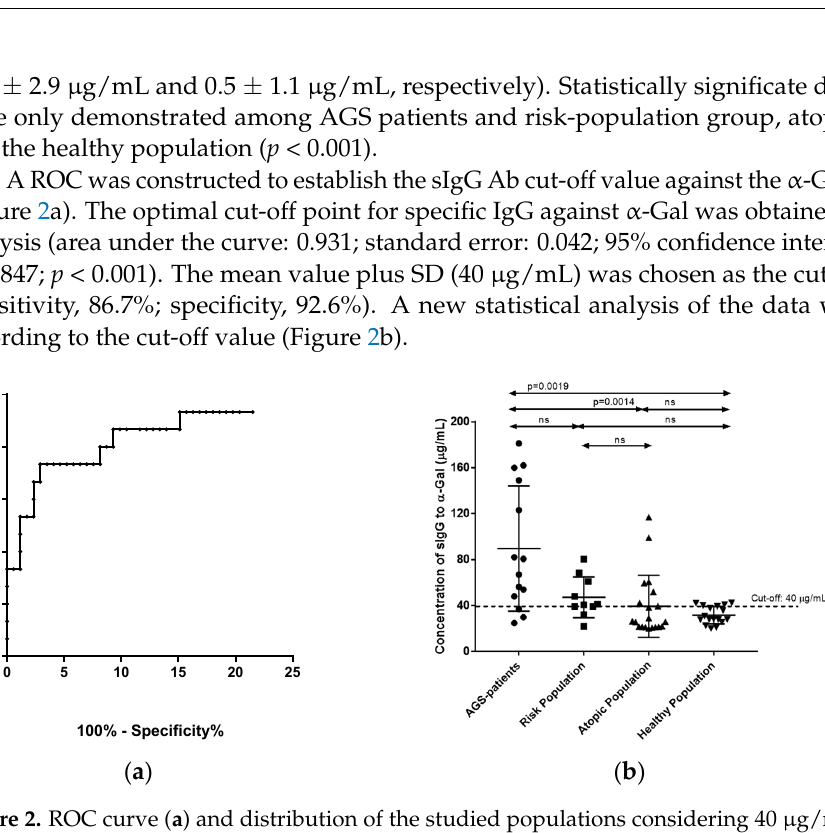
Figure 1. Concentrations of the sIgE ( a ) and sIgG ( b ) antibodies specific to α -Gal in the studied populations.